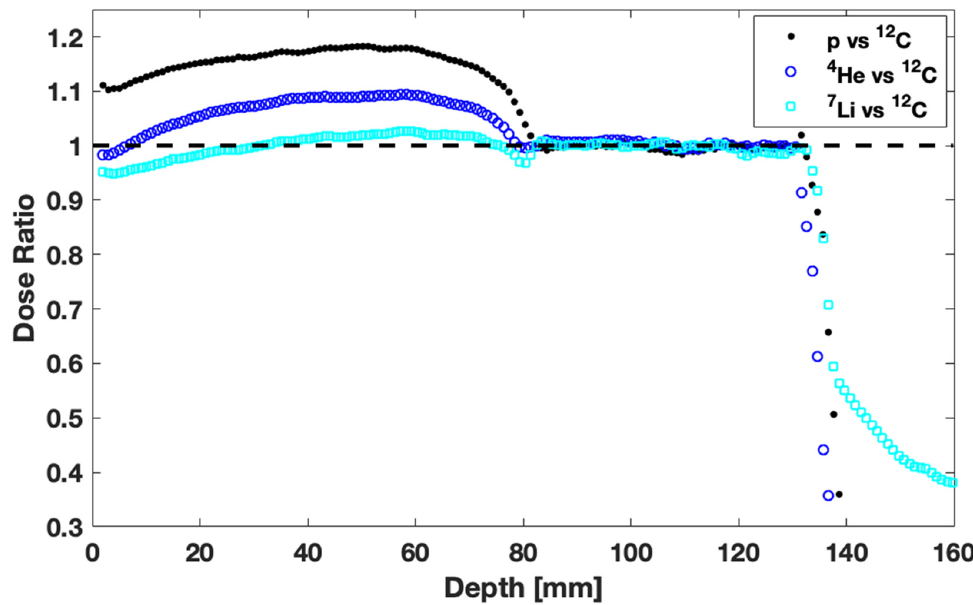
Figure 6. Comparison of p, 4 He, 7 Li, and 12 C ion beams. The ratio of corresponding biologically optimized doses, normalized at the center of the SOBP, is presented as a function of depth.